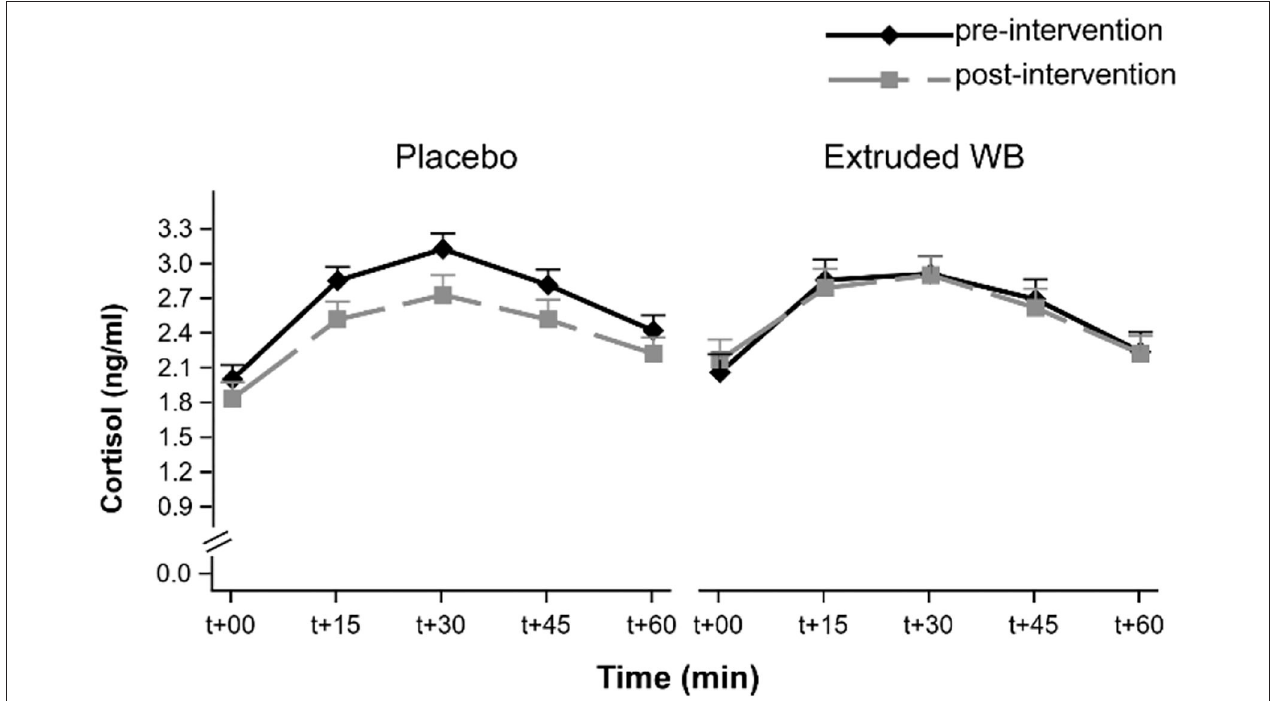
FIGURE 4 | Cortisol awakening response (CAR) at pre- and post-intervention visits. CAR was not modulated by consumption of placebo nor extruded WB. T + 00 represents time upon waking. Graphs show the means of transformed cortisol [transformed_cortisol = ((cortisol + 1)**0.25–1)/0.25] concentrations ±